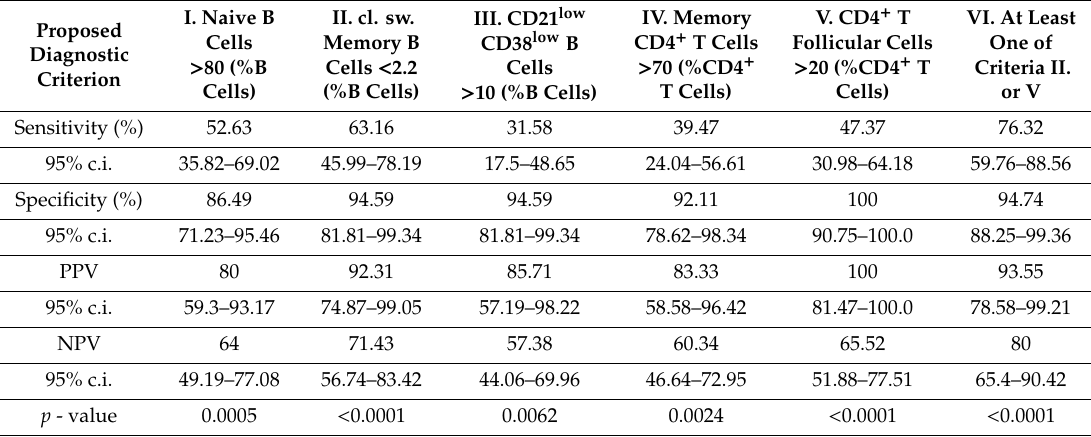
Table 3. Diagnostic e ffi cacy of peripheral lymphocyte subset counts for di ff erentiation of primary from secondary